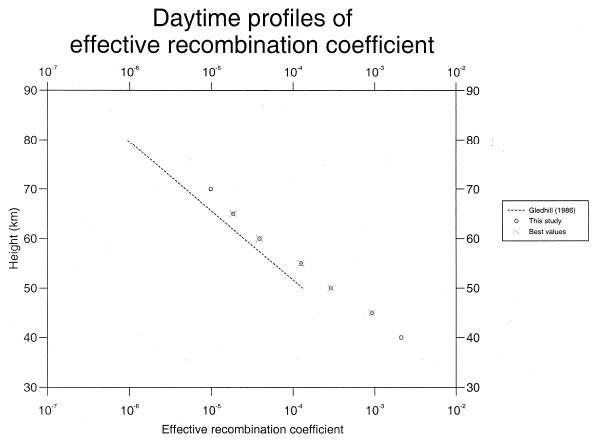
Fig. 11. Effective recombination coefficients for daytime derived by the present method, compared with Gledhill’s (1986) values.